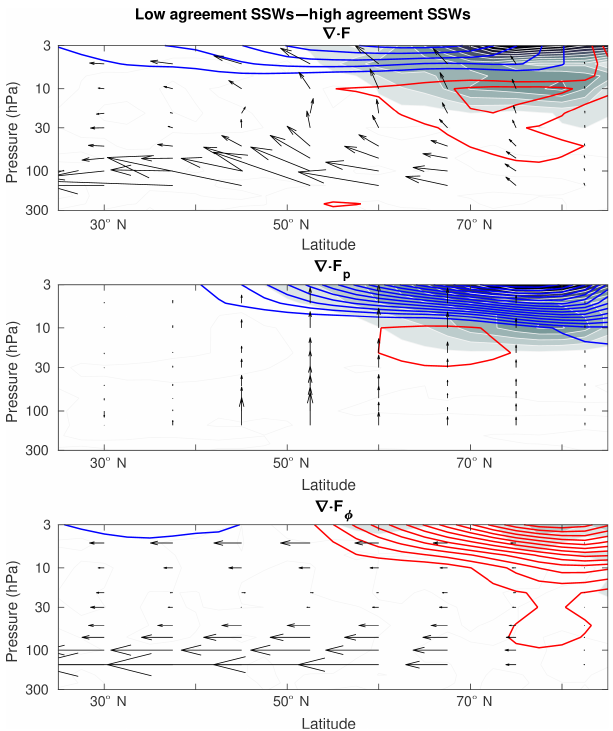
Figure 12. Difference in EP flux (arrows) and its divergence (con- tours) between HASSWs and LASSWs. All quantities are aver- aged over lags − 7 to 2 days. EP flux convergence and divergence are contoured in red and blue, respectively, with an interval of 2.5ms − 1 day − 1 . Differences in inter-reanalysis spread are shown in grey with a shading interval of 1ms − 1 day − 1 . Only LRE mem- bers are considered in this